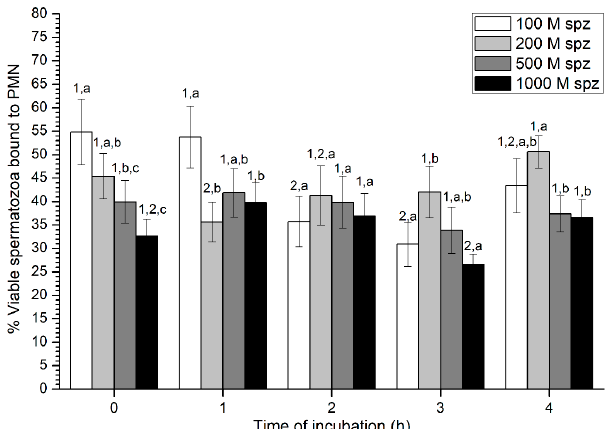
Figure 7. Percentages of viable spermatozoa bound to PMN after incubation with four di ff erent sperm concentrations (100 × 10 6 , 250 × 10 6 , 500 × 10 6 , and 1000 × 10 6 spermatozoa / mL) for 4 h (Experiment 3). Di ff erent superscripts (a, b) mean significant ( p < 0.05) di ff erences between treatments within a given time point, and di ff erent numbers (1, 2) mean significant ( p < 0.05) di ff erences between incubation times within a given treatment. Data are shown as mean ± SEM for seven experiments. PMN concentration: 100 × 10 6 PMN / mL.